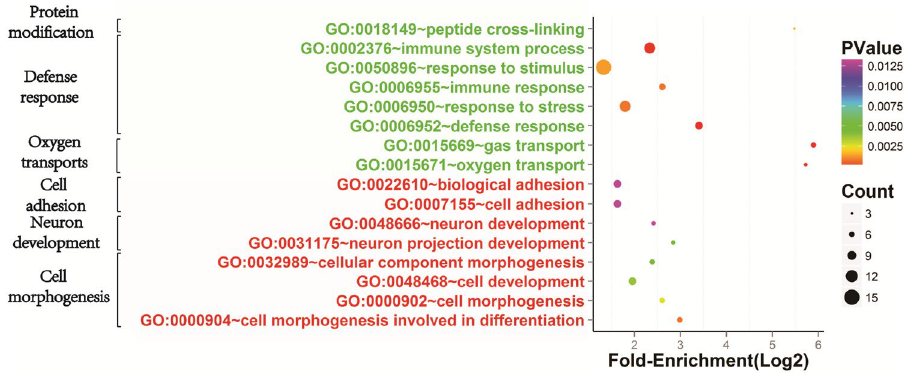
Figure 13. Gene ontology (GO) analysis of differentially expressed genes (DEGs) in resistant group compared to susceptible group on day 35. Circle represents enrichment significance of DEGs. Circle area represents number of DEGs followed in each category. Green and red colour of GO name indicates downregulation and upregulation, respectively.